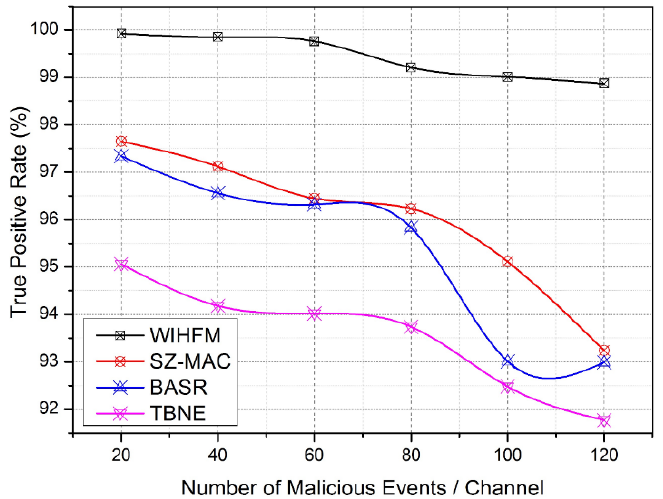
Figure 11. True Positive